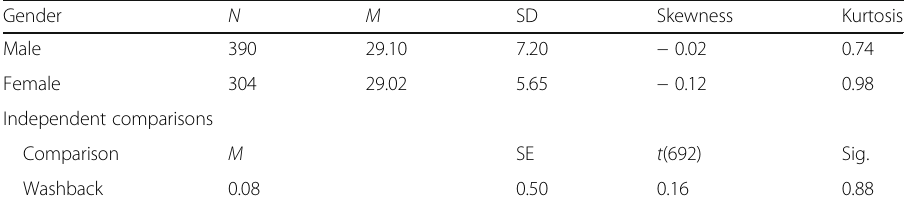
Table 4 The t test for independent samples comparing the mean difference in the strength of washback experienced between male and female students